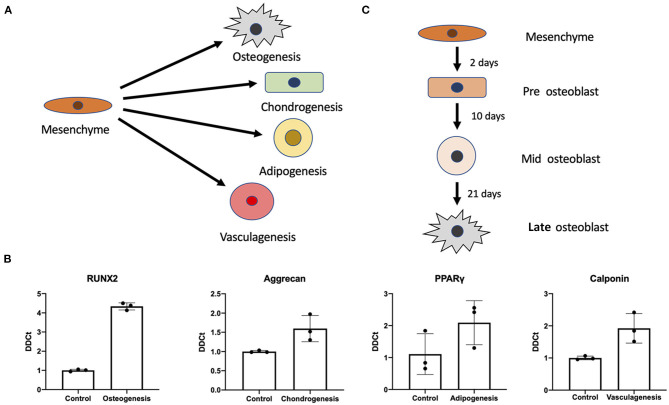
Mesenchymal stem cell differentiation potential. Differentiation potential of mesenchymal stem cells. (A) Visual representation of the different cellular iMSCs have potential to generate (osteogenic, chondrogenic, adipogenic, and vasculagenic lineages). RT-qPCR confirms differentiation of these four lineages by expression of commonly used markers RUNX2, aggrecan, PPARgamma, calponin (respectively) (B). Variant time course of osteoblastic differentiation that was interrogated to check time points for pre-osteoblast, mid-osteoblast and mature osteoblast phenotype (C).